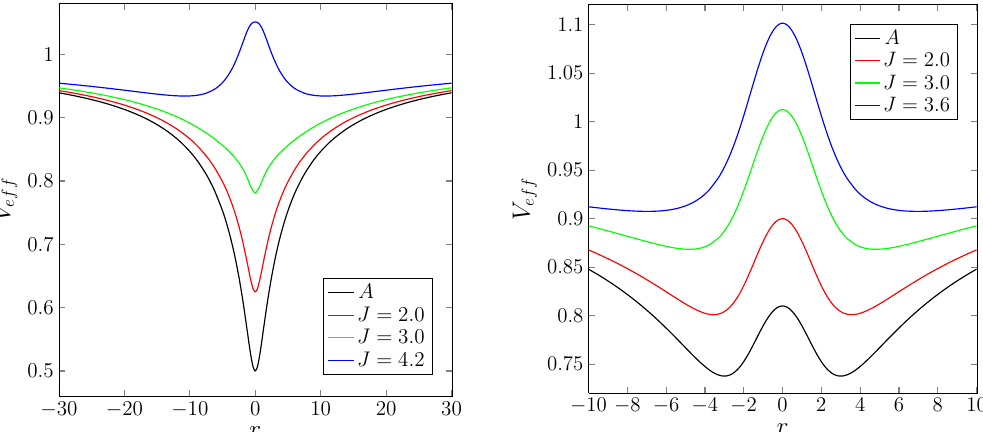
Figure 1. The effective potentials V ef f ( r , J ) of massive particles and (if J = 0) the metric function A ( r ) = V ef f ( r ,0 ) for the ansatz (28): a = 1 ( left panel ) and a = 9 ( right panel ).